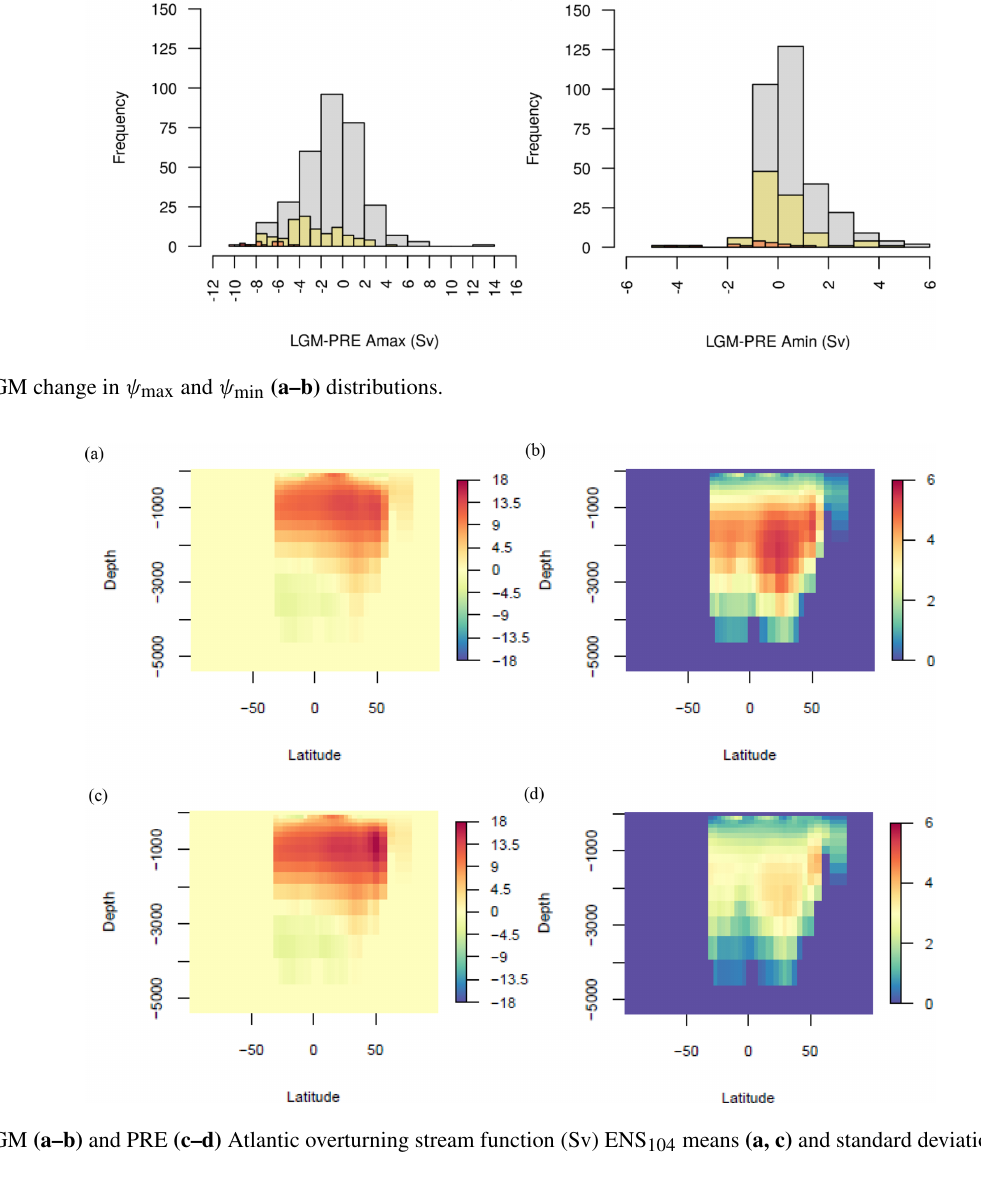
ship between (cid:49)ψ min and (cid:49) CO 2 ( r = − 0 . 42). The relation- ships are reproduced in ENS 315 ( r = 0 . 59 and r = − 0 .